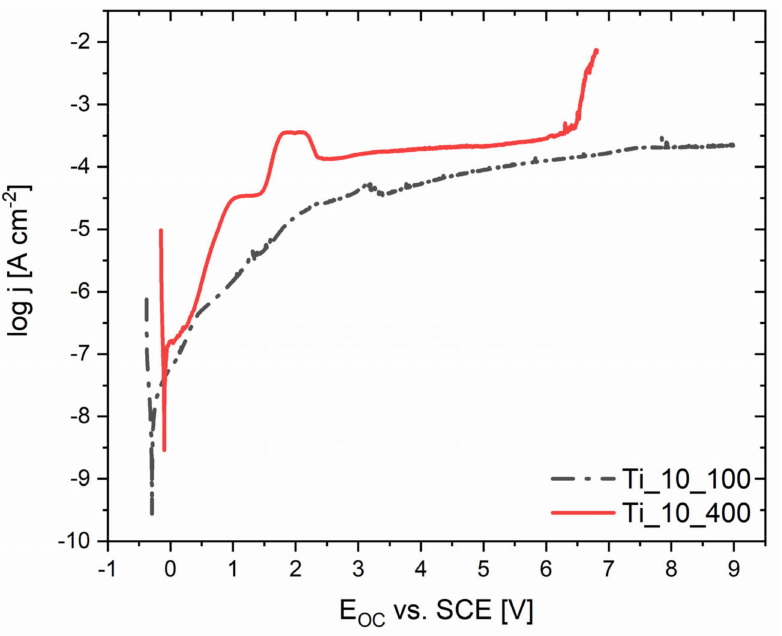
Figure 11. Anodic polarization curves for the Ti_10_100 and Ti_10_400 electrodes in Ringer’s solution at 37 ◦